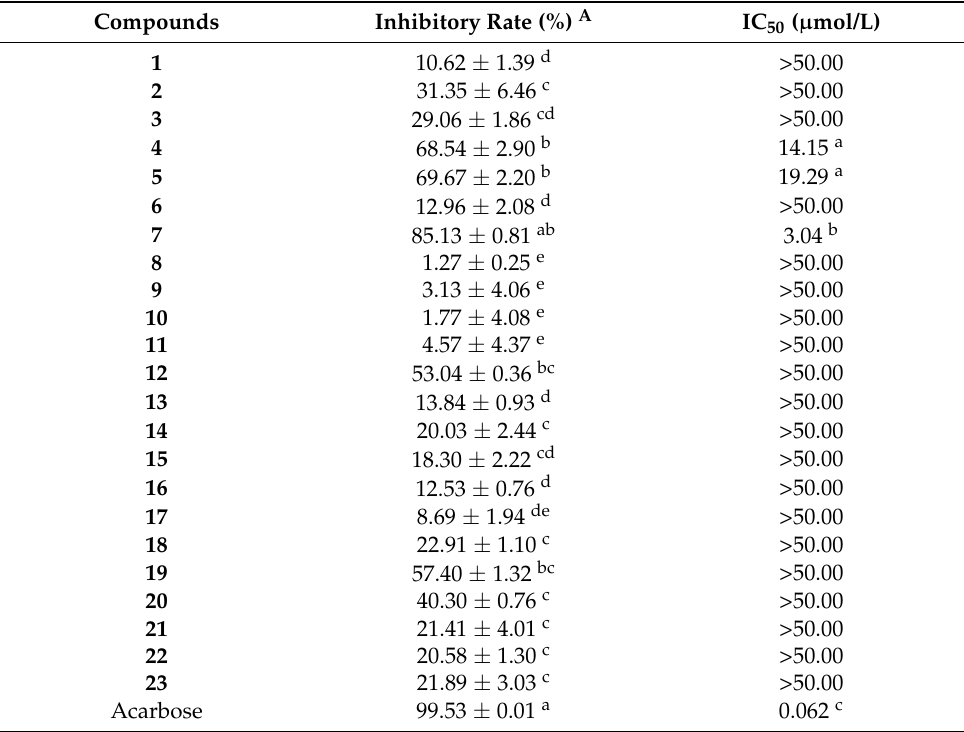
Table 3. α -Glucosidase inhibitory activities of compounds 1 – 23 from T. grandis .